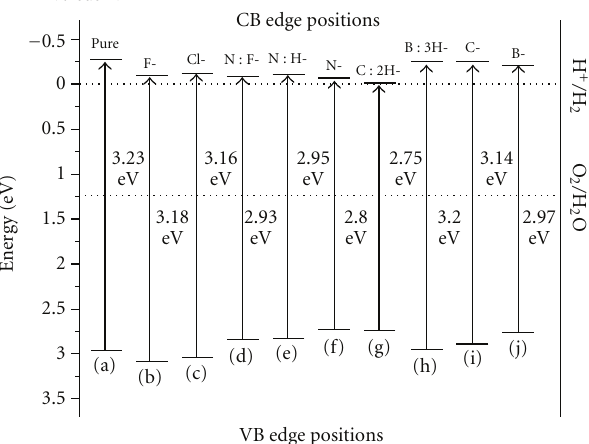
Figure 5: Calculated edge positions of conduction band and valence band for pure and nonmetal doped anatase TiO 2